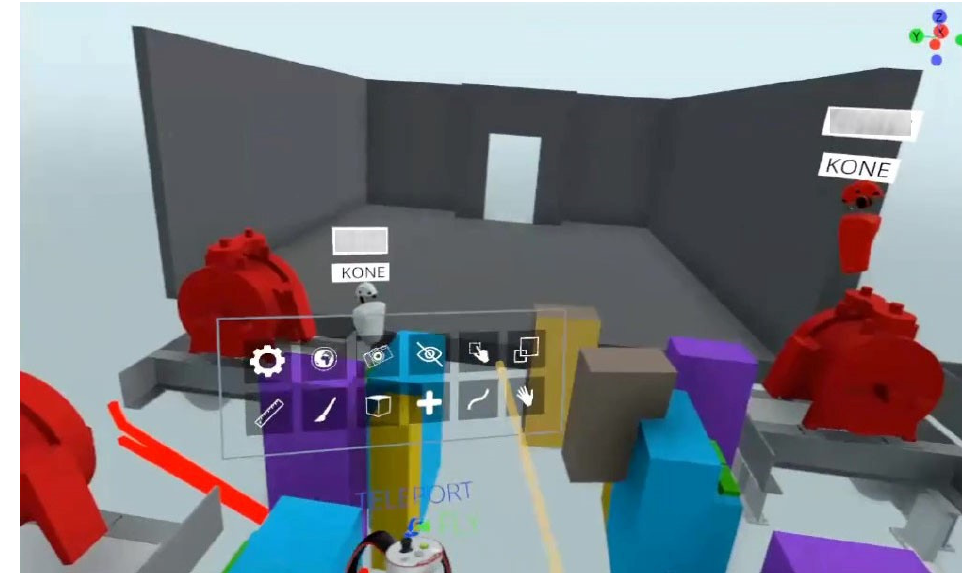
Figure 13. A VR scene of components falling apart due to a synchronization issue, Case 4.